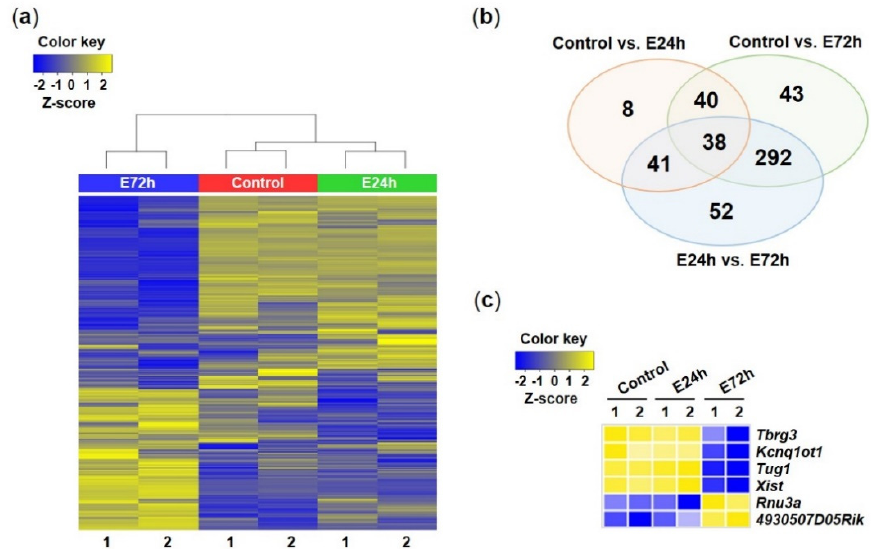
Figure 4. Changes of lncRNAs among control and ethanol-treated groups. ( a ) Heatmap generated from hierarchical clustering analysis of differentially expressed lncRNAs among control and ethanol-treated (E24h and E72h) groups. ( b ) Venn diagram showing overlap of lncRNAs among control, E24h, and E72h groups. ( c ) lncRNAs selected from total transcripts for RT-qPCR.